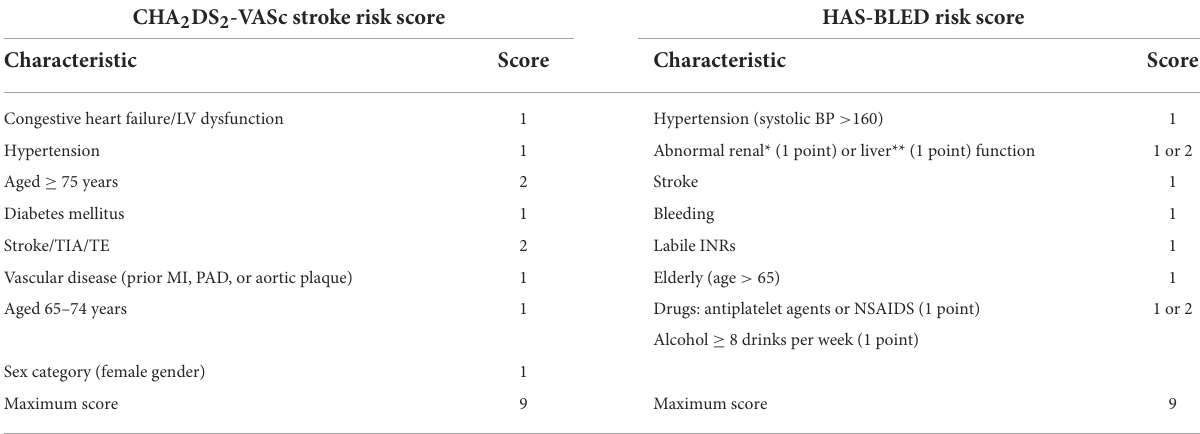
* Chronicdialysisorrenaltransplantationorserumcreatinine ≥ 2.26mg/dl. ** Chronichepaticdisease,bilirubin > 2xupperlimitofnormal,inassociationwithaspartatetransaminase/alaninetransaminase/alkalinephosphatase > 3xupperlimitofnormal. Adaptedfromreference(